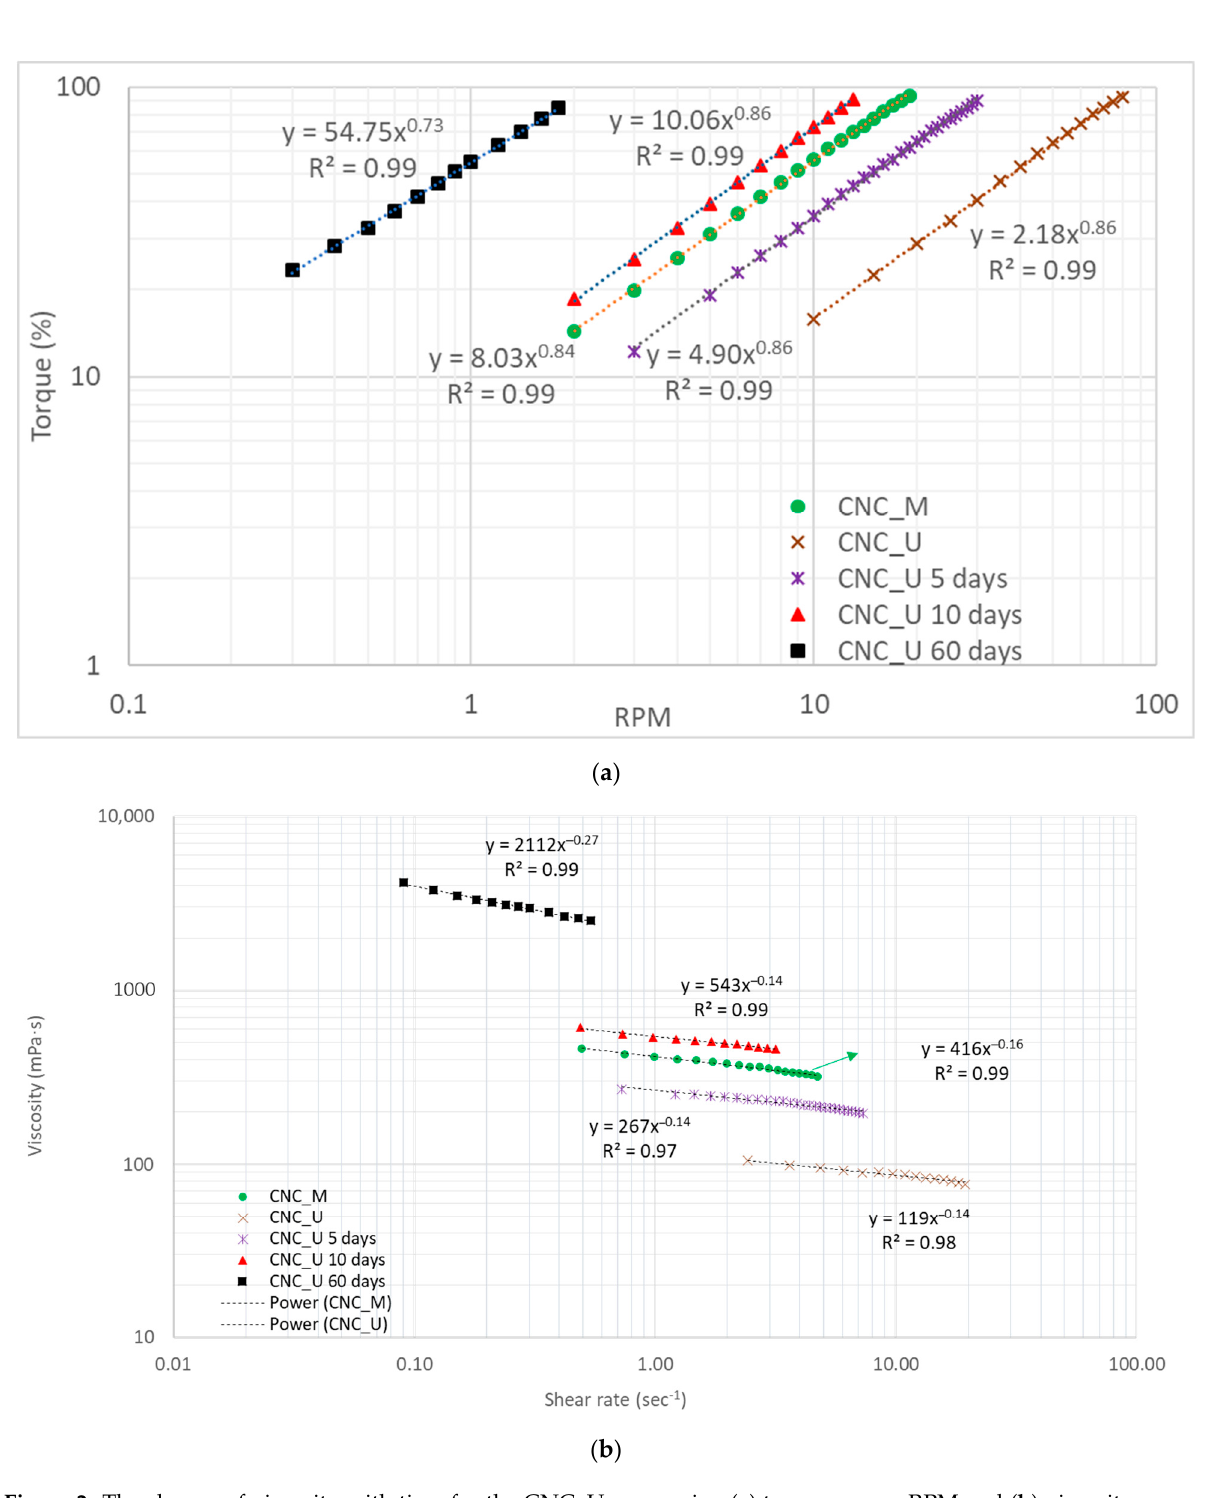
Figure 2. The change of viscosity with time for the CNC_U suspension ( a ) torque versus RPM and ( b ) viscosity versus shear rate.